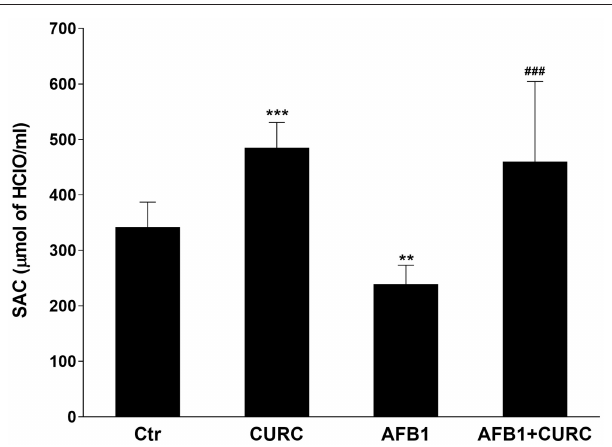
FIGURE 2 | Effects of Curcumin (CURC) and Aflatoxin B1 (AFB1) on serum antioxidant capacity (SAC) in broilers at the end of treatment (T10). Ctr, control group; CURC, Curcumin group; AFB1, Aflatoxin B1 group; AFB1 + CURC, Aflatoxin B1 group plus Curcumin. Data are expressed as mean ± standard